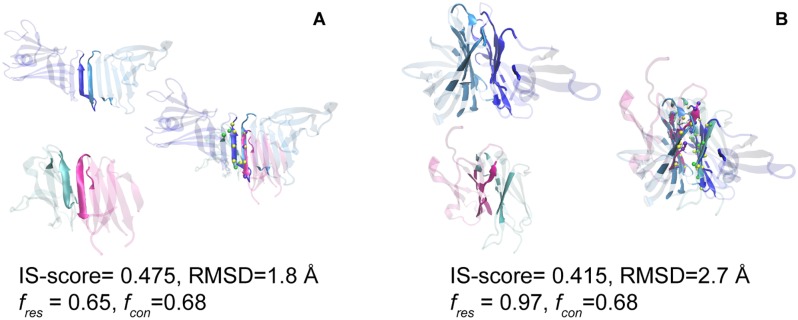
Examples of similar domain-domain and protein-protein interfaces.Two domains of template (domain-domain interface) protein are shown in blue and sky blue colors, while two interacting proteins are shown in pink and cyan colors. The aligned C-alpha residues are shown in green and yellow for target and template structures respectively. A) Two domains of outer surface protein A (domains 1 and 2 of 1ospO) is aligned with human major histocompatability complex with T-cell receptor (4pjeC (domain C02/ 4pjeE (domain E01). B) Structural interface alignment of protein of unknown function (domains 1 and 2 of 2o62A) is complexed with antibody fragments (3qnzB (domain B02)/3qnzA (domain A02). The coordinates of structures were obtained from the PDB. In superposed structures, the interface and non-interface regions are shown in solid and transparent color respectively. Molecular images are generated using VMD.